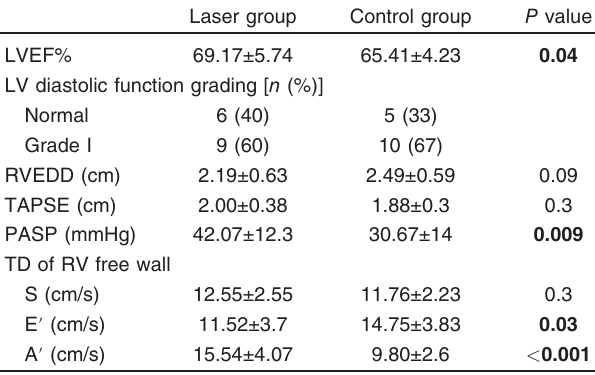
Table 2 Baseline echocardiographic measurement in the study group